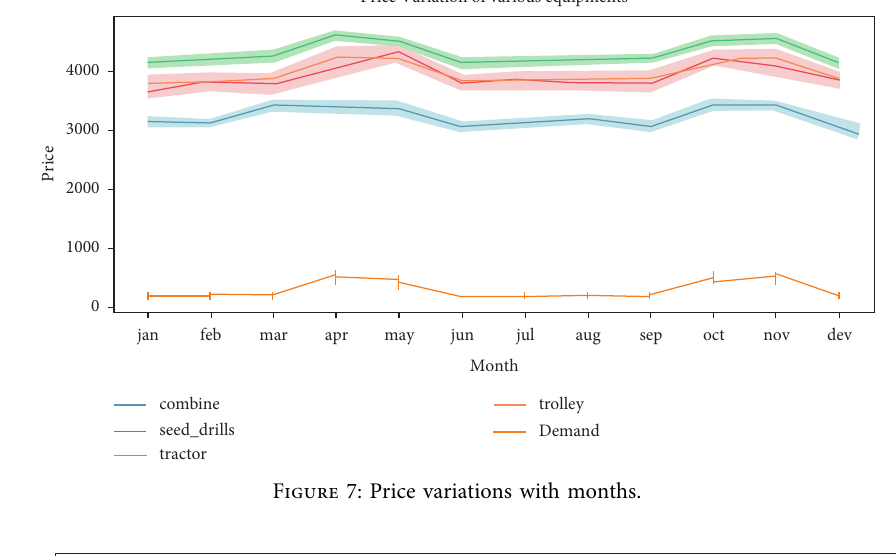
Figure 7: Price variations with months.